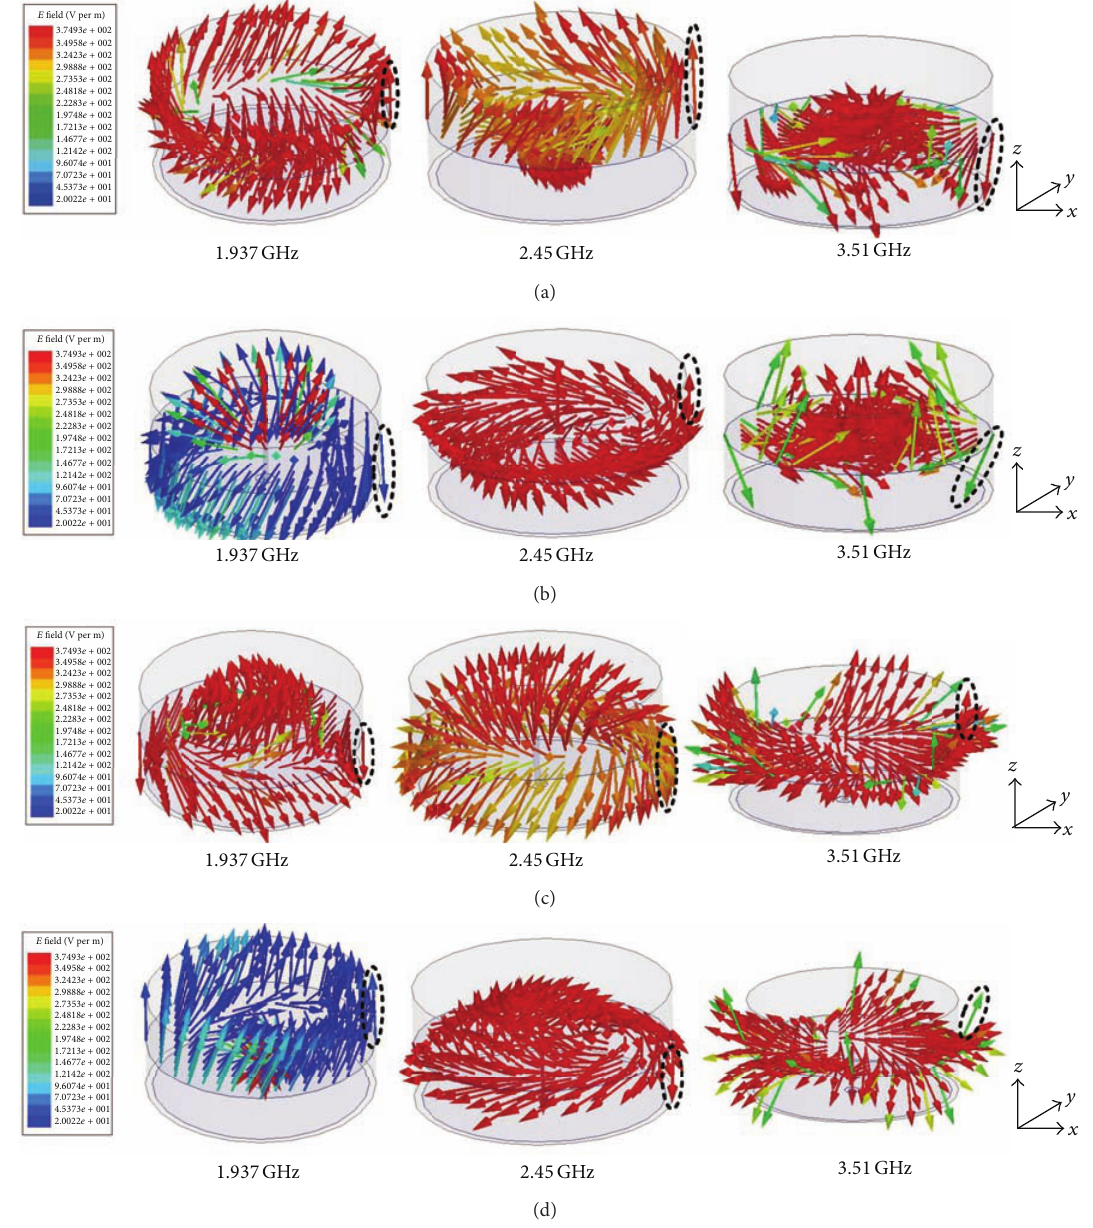
Figure 4: Simulated E fields inside the DRA at the three resonant frequencies with four phase angles: (a) 0 ∘ , (b) 90 ∘ , (c) 180 ∘ , and (d) 270 ∘ .